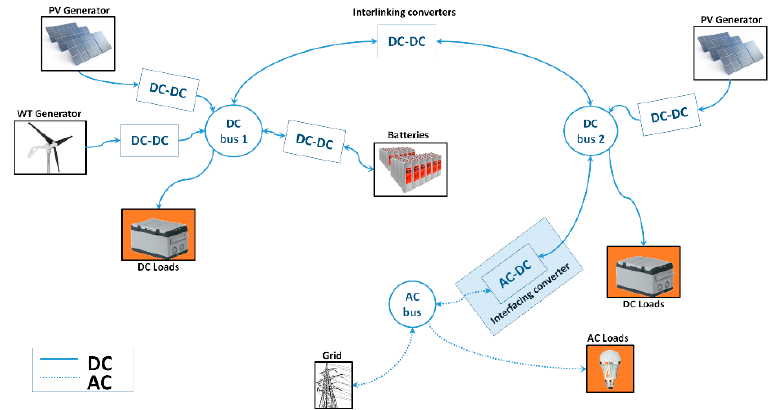
Figure 9. Microgrid architecture selected as a case study.